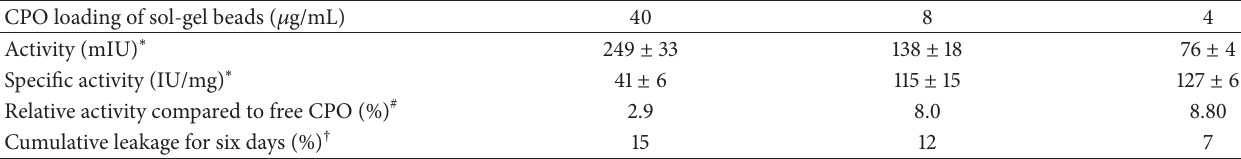
Table 2: Catalytic performance of sol-gel beads loaded with different CPO amounts.